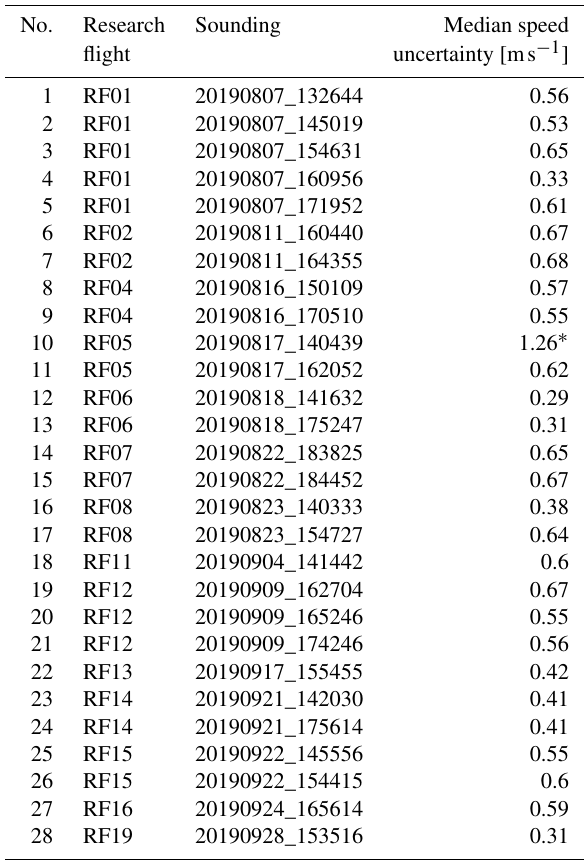
Table 3. Soundings with degraded GPS performance. The speed uncertainty is reported by the GPS module.